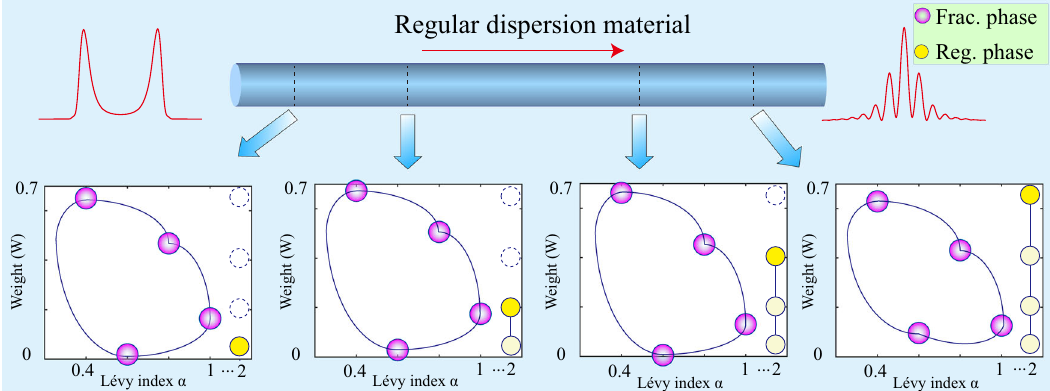
Fig. 4 | The demonstration of the “ fractional-phase protection ” . Here, the central bar represents a waveguide with nonfractional GVD, and the left plot is the initial intensity pro fi le with the fractional phase, as produced by the shaper with ( α =1.20, L frac =70m), and the right plot shows the corresponding output pro fi le, affected by the action of the second-order GVD in the course of the propagation. The four bottom panels show the weightings and LI for the reconstructed phase structure given by Eq. (14) for propagation distances z =1, 3, 6, and 9m, respec- tively. In these panels, the four purple balls represent four different fractional-